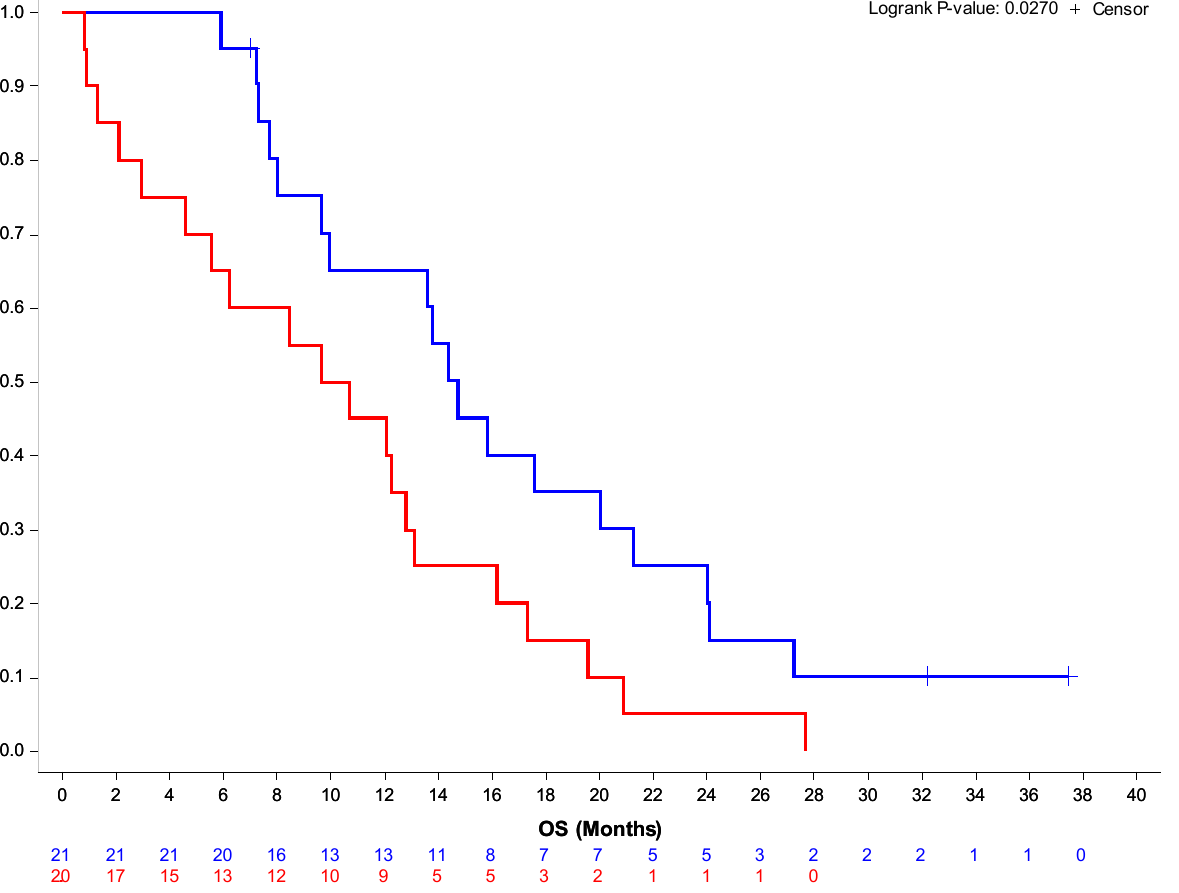
Figure 1. Overall survival according to β ig-h3 serum levels. Overall survival was calculated from the date of initial diagnosis to the date of death or censored to the date of the latest news. Survival curves with associated log-rank tests were generated using the Kaplan–Meier method. Table 2. Analysis for overall survival.